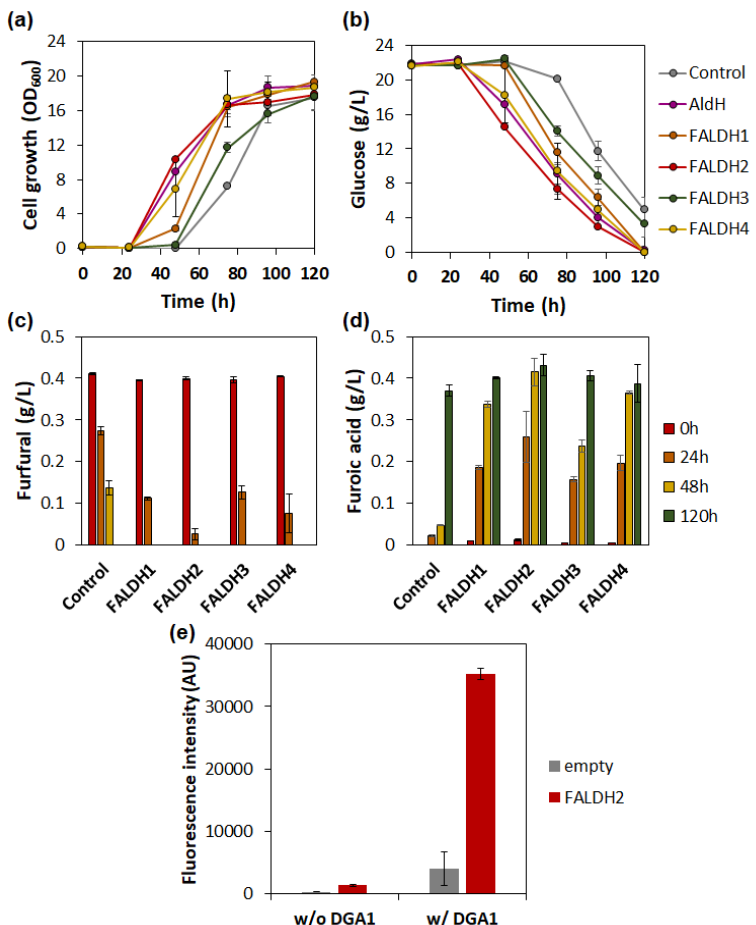
Figure 5. Effect of FALDH overexpression on the cell growth and lipid production of Y. lipolytica in the presence of 0.4 g/L furfural. Cell growth ( a ), glucose consumption ( b ), and the conversion of furfural ( c ) into furoic acid ( d ) of Y. lipolytica expressing various fatty aldehyde dehydrogenases. Lipid production ( e ) was measured by using a (Nile ‐ red assay in the Y. lipolytica expressing FALDH2 and FALDH2/DGA1 at 96 h of incubation. Error bars represent the standard deviation of biological triplicates.